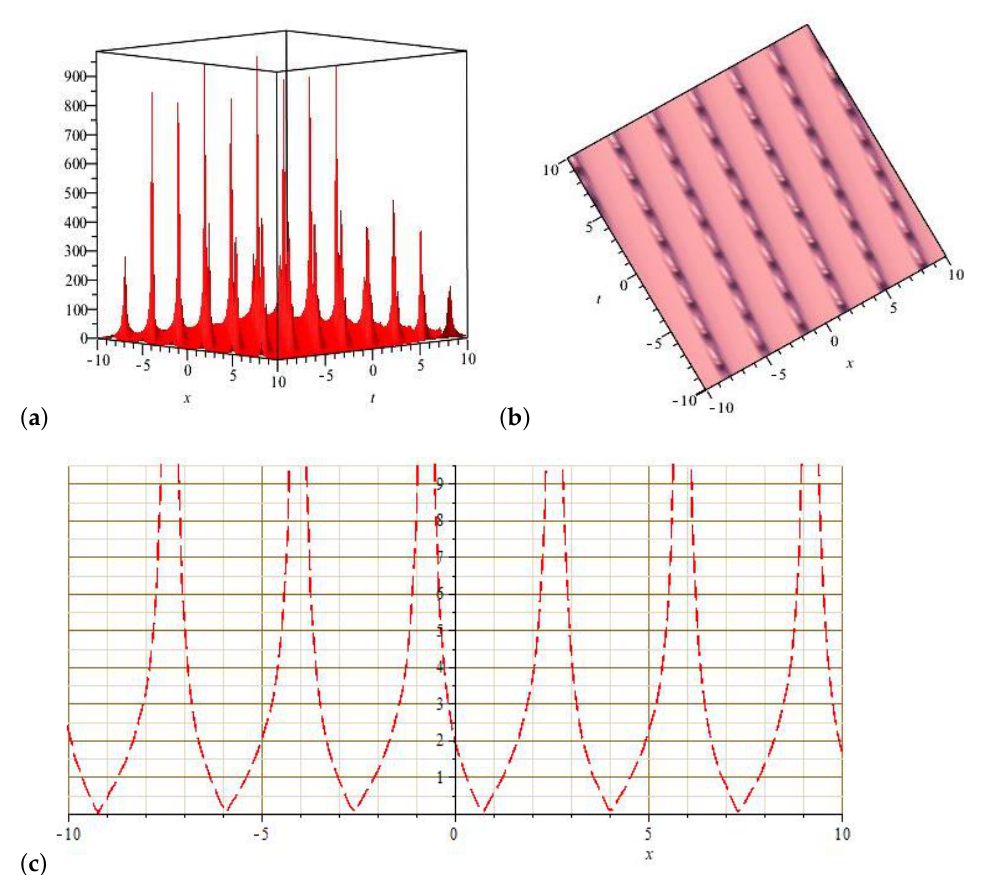
Figure 1. Graphical view of | Q 3 ( (cid:36) ) | for A − 1 = 1.67, c 1 = 0.61, (cid:101) = 0.1, c 2 = 1.26, (cid:36) 0 = 1.06, A 0 = 0.25, c 0 = 0.79: ( a ) 3D plot, ( b ) contour plot, and ( c ) 2D plot at t =